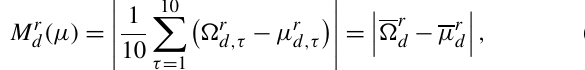
Figure 4. Number of heat periods (1961–2010) in France (Pru- dence 3) in summer from E-OBS o (solid line) and corresponding E-OBS link strength W (dashed line). The M’s denote the absolute mean difference within a decade between E-OBS standard approach and the E-OBS link strength after normalization (cf. Eq.